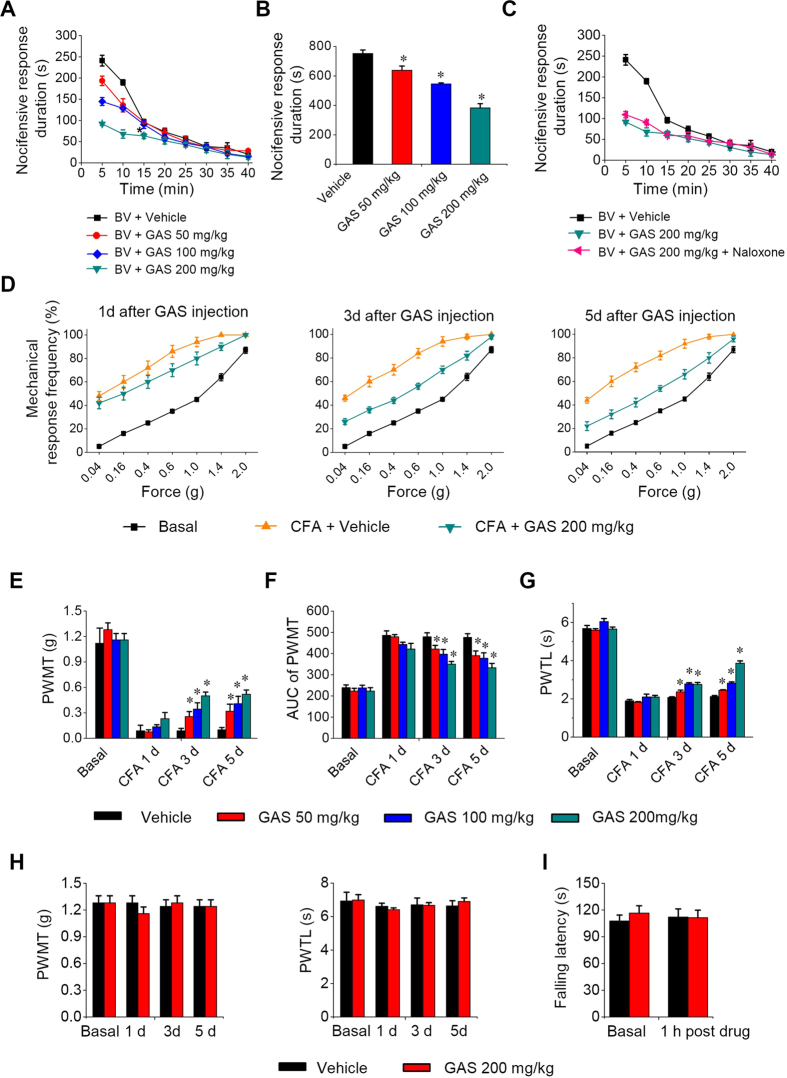
Intraperitoneal (i.p.) administration of GAS attenuated the development of spontaneous pain, mechanical and thermal pain hypersensitivity induced by paw inflammation.(A,B) The dose-dependent inhibitory effect of i.p. GAS (50, 100 and 200 mg/kg body weight) on the time course (A) and total response duration (B) of bee-venom-induced spontaneous pain (n = 8, P < 0.05). (C) The analgesic effect of GAS was not reversed by naloxone, an opioid receptor antagonist (n = 5, P > 0.05). (D) Representative traces showing the attenuation of CFA-induced mechanical pain hypersensitivity by i.p. GAS (200 mg/kg) at different time points after GAS administration. (E, F) Quantitative summary of the inhibition of i.p. GAS (50, 100 and 200 mg/kg) on the drop of paw withdrawal mechanical threshold (PWMT) (E), represented as integrated area under the curve, AUC, in (F) induced by CFA inflammation, indicating an analgesic effect on mechanical pain hypersensitivity (n = 8, P < 0.05). (G) Quantitative summary showing depression of thermal hyperalgesia by i.p. GAS (50, 100 and 200 mg/kg), manifesting as a prolonged paw withdrawal thermal latency (PWTL) to radiant heat stimuli compared to vehicle (n = 8, P < 0.05). (H,I) Neither basal nociception to mechanical and thermal stimuli (H) nor motor coordination (I) was altered by i.p. GAS (200 mg/kg) (n = 8, P > 0.05). All data are represented as mean ± S.E.M. *P < 0.05. PWMT, paw withdrawal mechanical threshold; PWTL, paw withdrawal thermal latency.